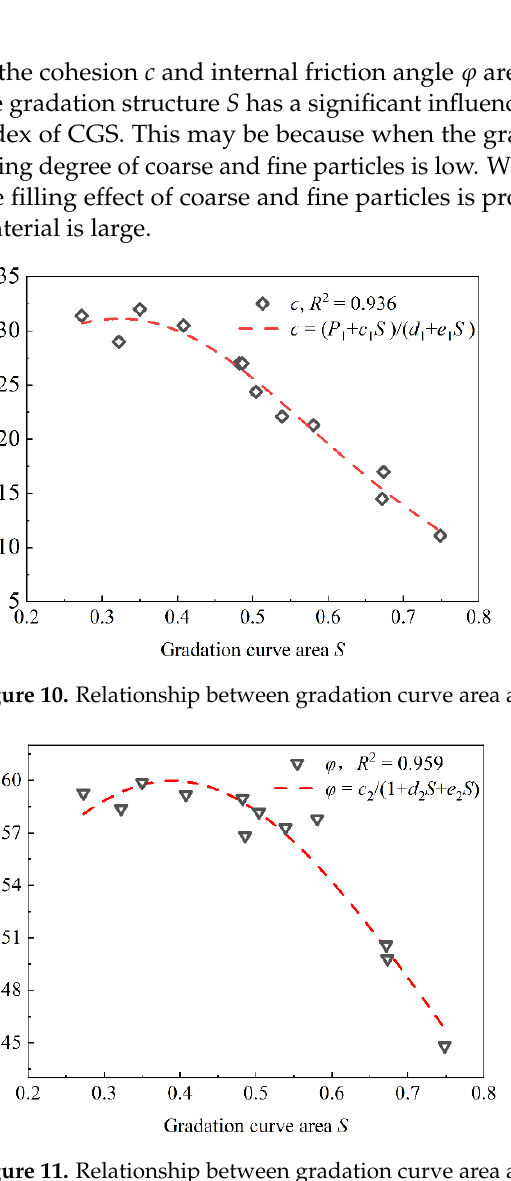
Figure 11. Relationship between gradation curve area and internal friction angle.